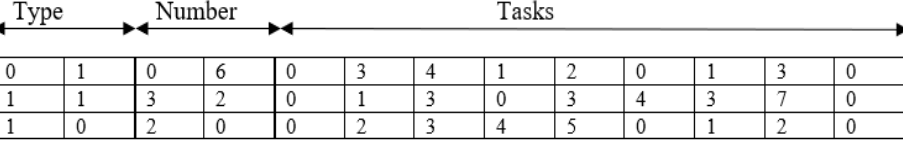
Figure 2. Structure of the genetic algorithm.